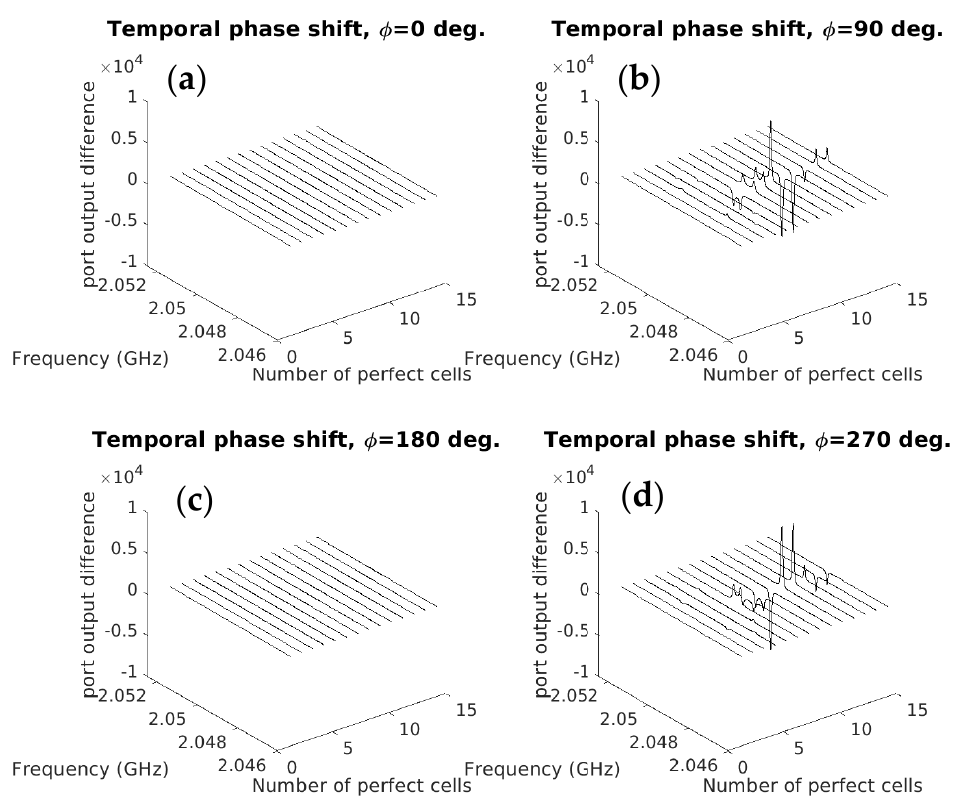
Figure 7. Spectra of the difference between ports P 1 and P 2 in shape A (“ − o 4 × o N × o 4 − ”) as a function of the perfect cells number N between the two cavities, for four principal values of the temporal phase shift between the two sources in the cavity centers ( a – d ).